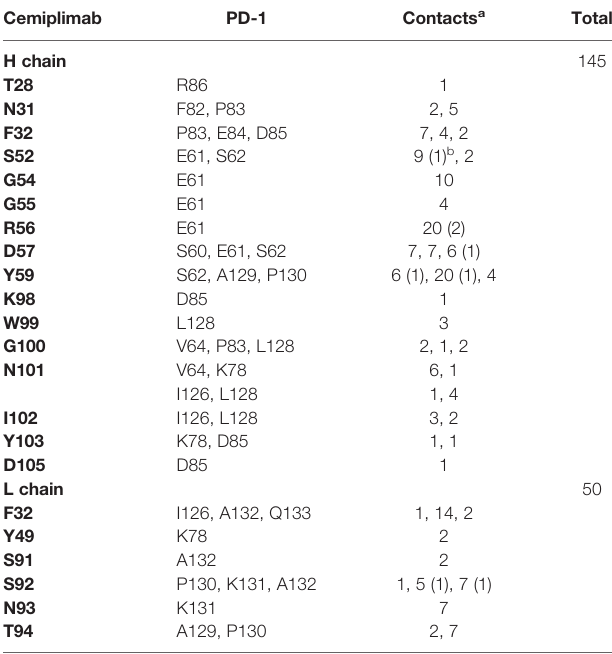
TABLE 2 | Residues contributed interaction between cemiplimab and PD-1.